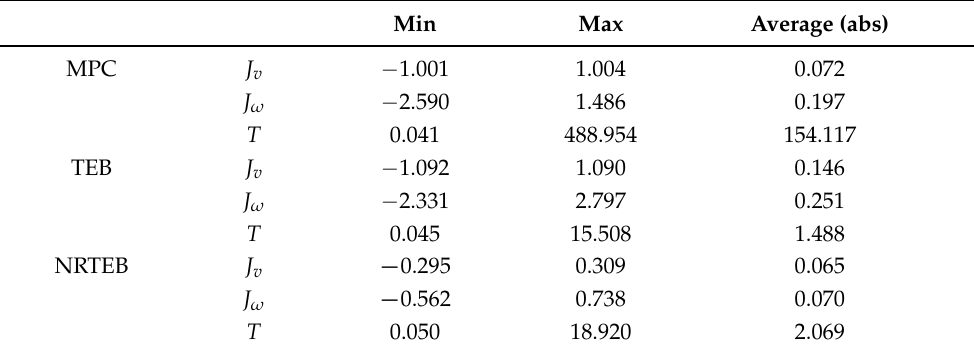
Table 4. Planning performance